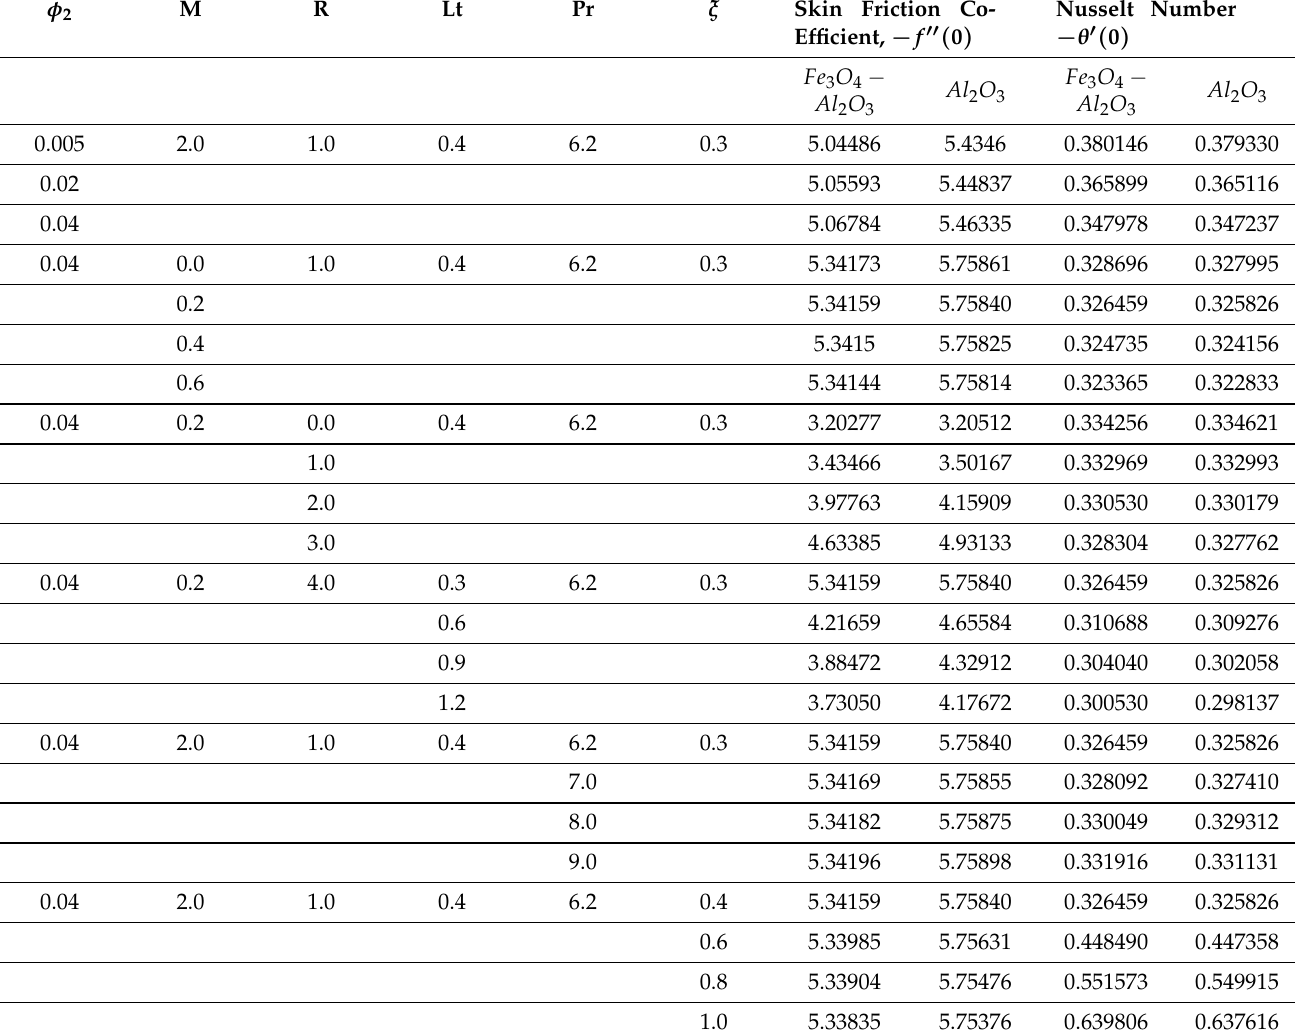
Table 3. The variation of the skin friction coefficient and Nusselt number for both the nano-fluid and the hybrid